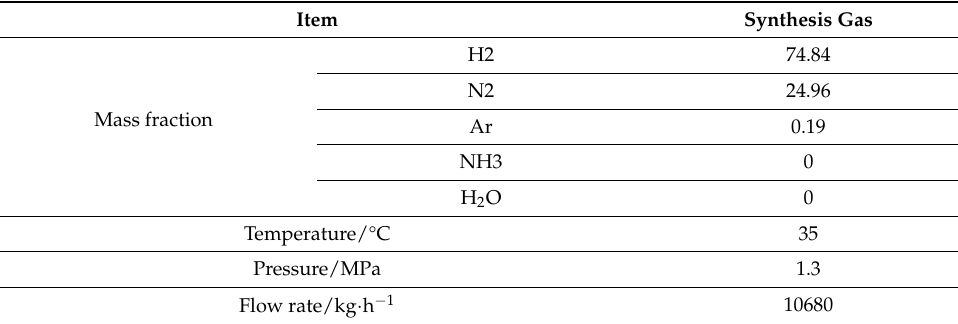
Table 4. Feed stream parameters.